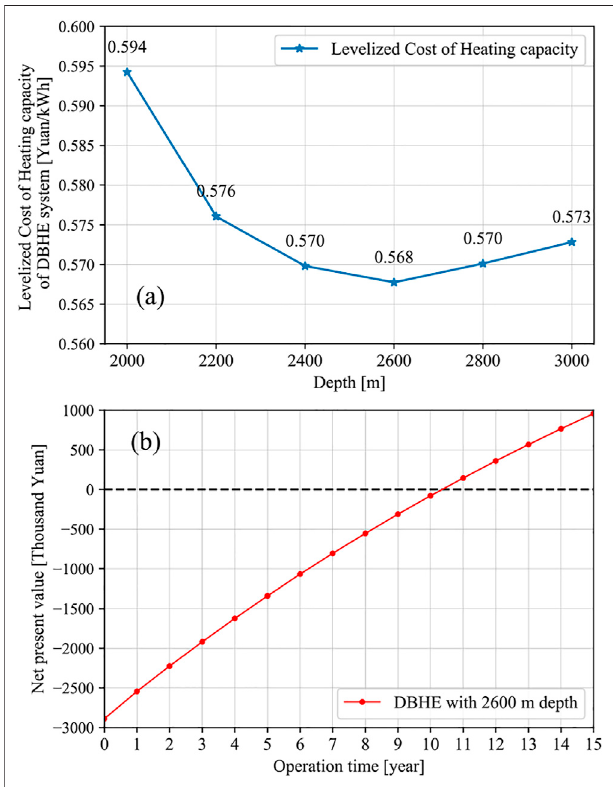
FIGURE 9 | The LCOH (A) and NPV (B) value for the DBHE heating system with different drilling depths.